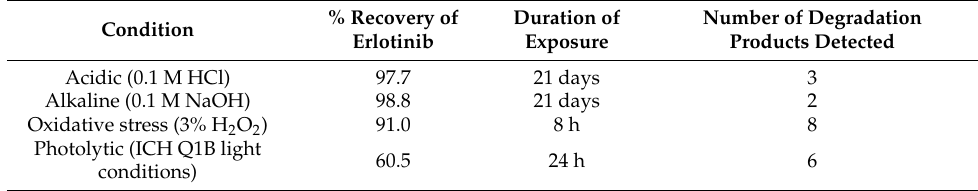
Table 1. Typical results of the forced degradation study. Condition